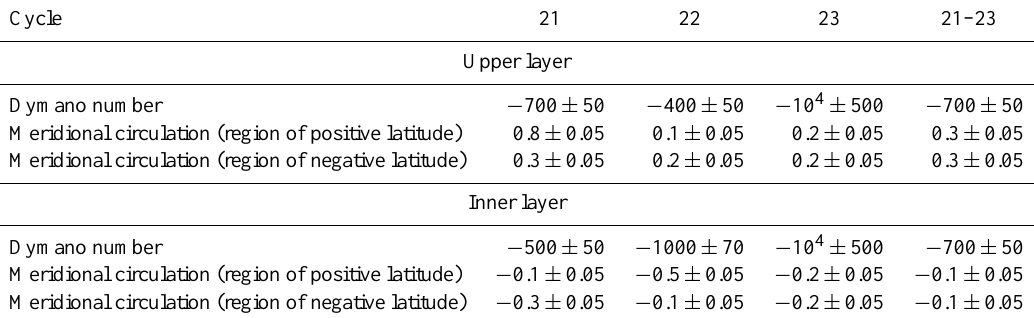
Table 1. Model parameters in cycles. Cycle Upper layer Dymano number − 700 ± 50 − 400 ± 50 − 10 4 ± 500 − 700 ± 50 Meridional circulation (region of positive latitude) 0.8 ± 0.05 0.1 ± 0.05 0.2 ± 0.05 0.3 ± 0.05 Meridional circulation (region of negative latitude) 0.3 ± 0.05 0.2 ± 0.05 0.2 ± 0.05 0.3 ± 0.05 Inner layer Dymano number − 500 ± 50 − 1000 ± 70 − 10 4 ± 500 − 700 ± 50 Meridional circulation (region of positive latitude) − 0.1 ± 0.05 − 0.5 ± 0.05 − 0.2 ± 0.05 − 0.1 ± 0.05 Meridional circulation (region of negative latitude) − 0.3 ± 0.05 − 0.1 ± 0.05 − 0.2 ± 0.05 − 0.1 ±